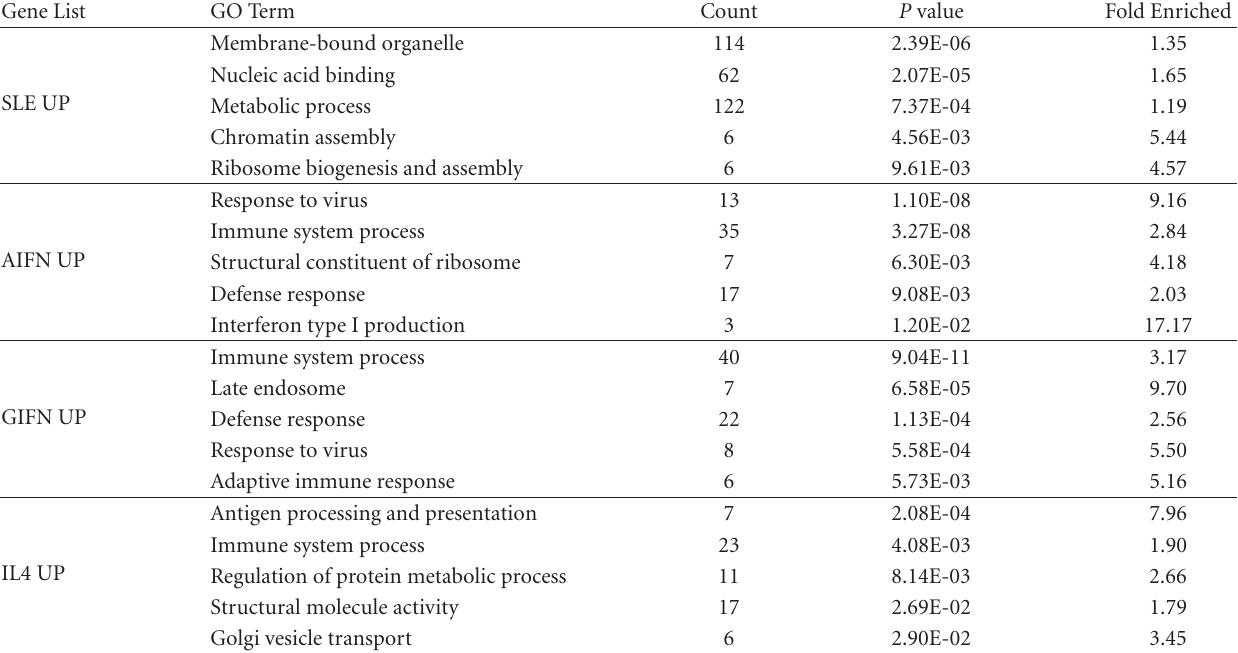
Table 2: DAVID analysis of H4ac gene